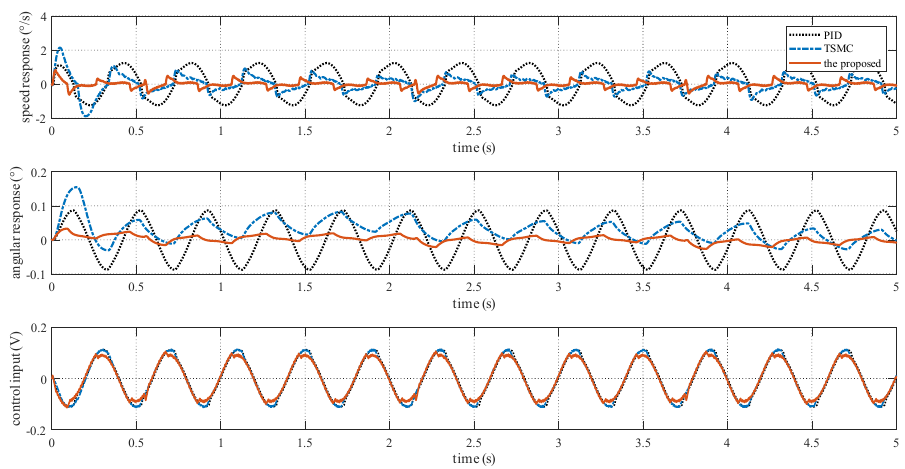
Figure 9. Simulation response curves under Case III.